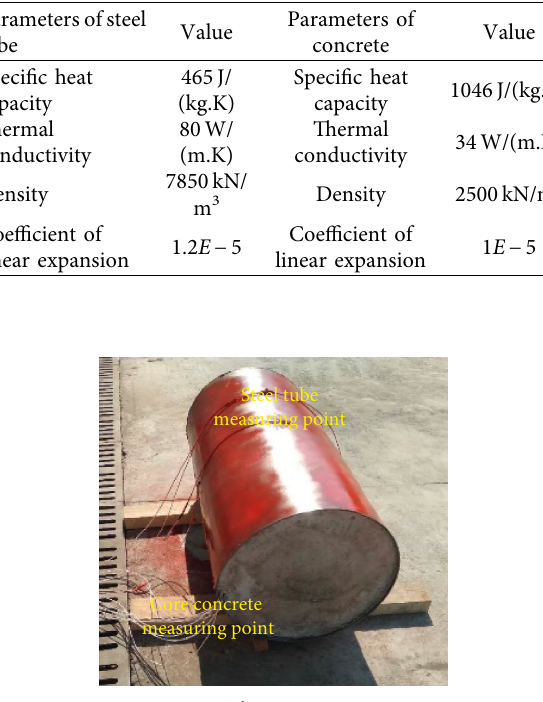
Figure 6: The test component.